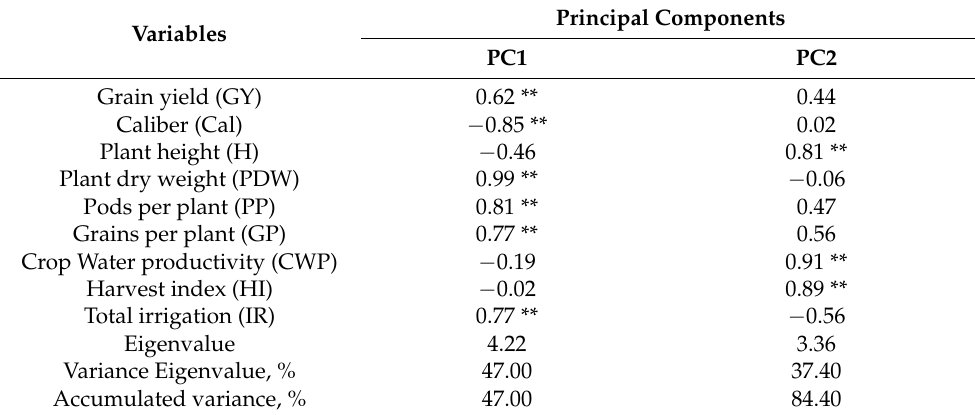
Table 9. Pearson correlation coefficients relating response variables with the two main principal components summarizing data of chickpea under different irrigation treatments, tested at Todos Santos, Baja California Sur,